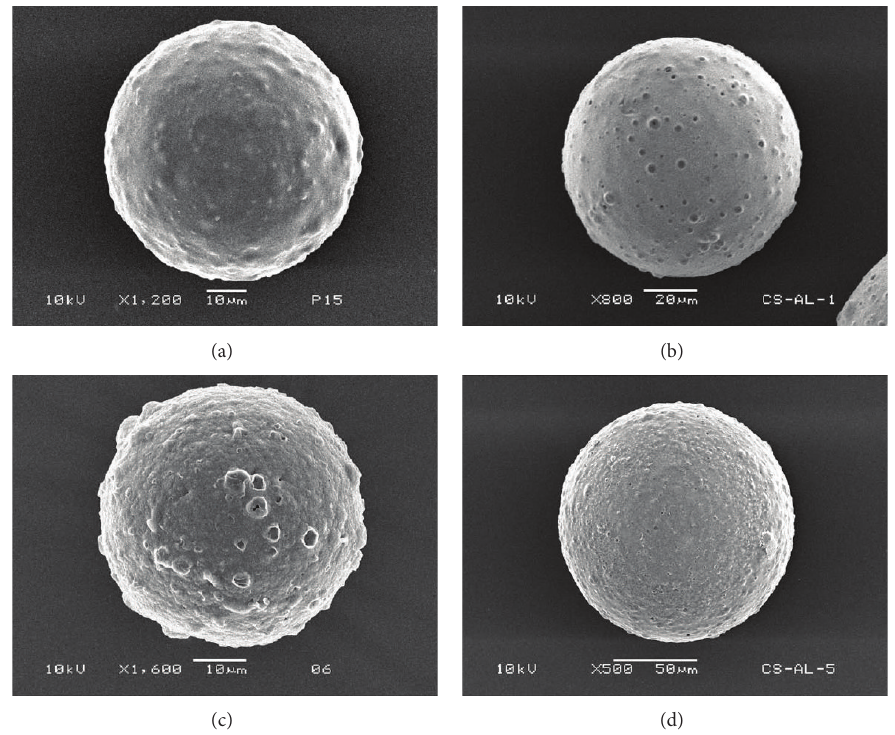
Figure 2: Expanded SEM images of drug-free microspheres of (a) 15kDa chitosan, (b) 100kDa chitosan, (c) potato starch, and (d) alginate. Bars = 10 𝜇 m for (a) and (c), 20 𝜇 m for (b), and 50 𝜇 m for